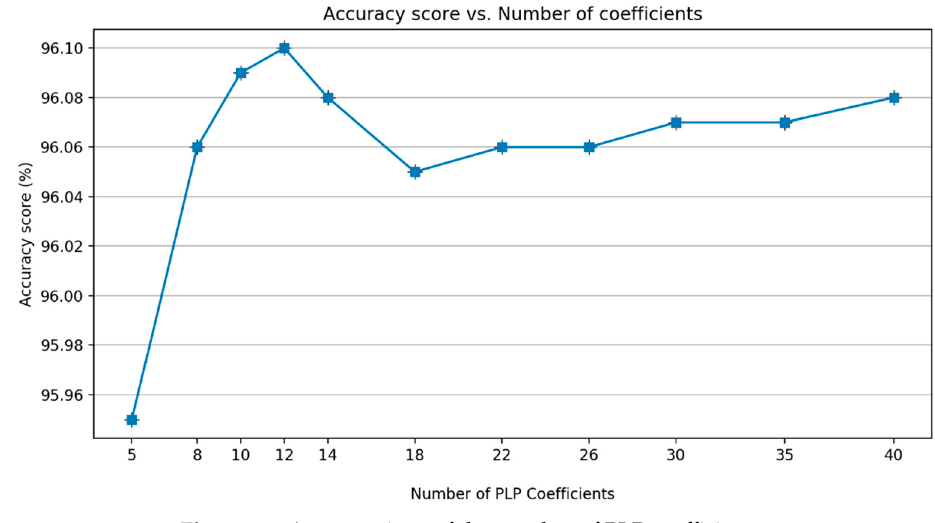
Figure 17. A comparison of the number of PLP coefficients.